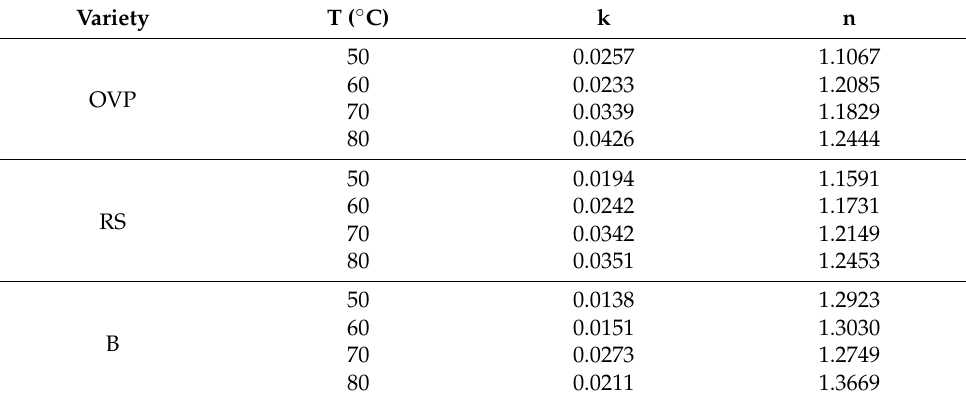
Table 3. Parameters of the Page model adjusted to experimental data of drying kinetics of germinated seeds of faba bean varieties, at temperatures of 50, 60, 70 and 80 °C.